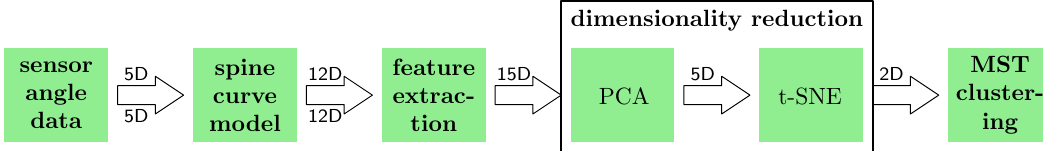
Figure 2. Overview of the processing pipeline used. Individual steps are marked by boxes, arrows indicate the direction of the pipeline. Each arrow is annotated with dimensionality of the data output by the preceding step. Two dimension labels indicate that the data from the two postures in each posture pair is not yet